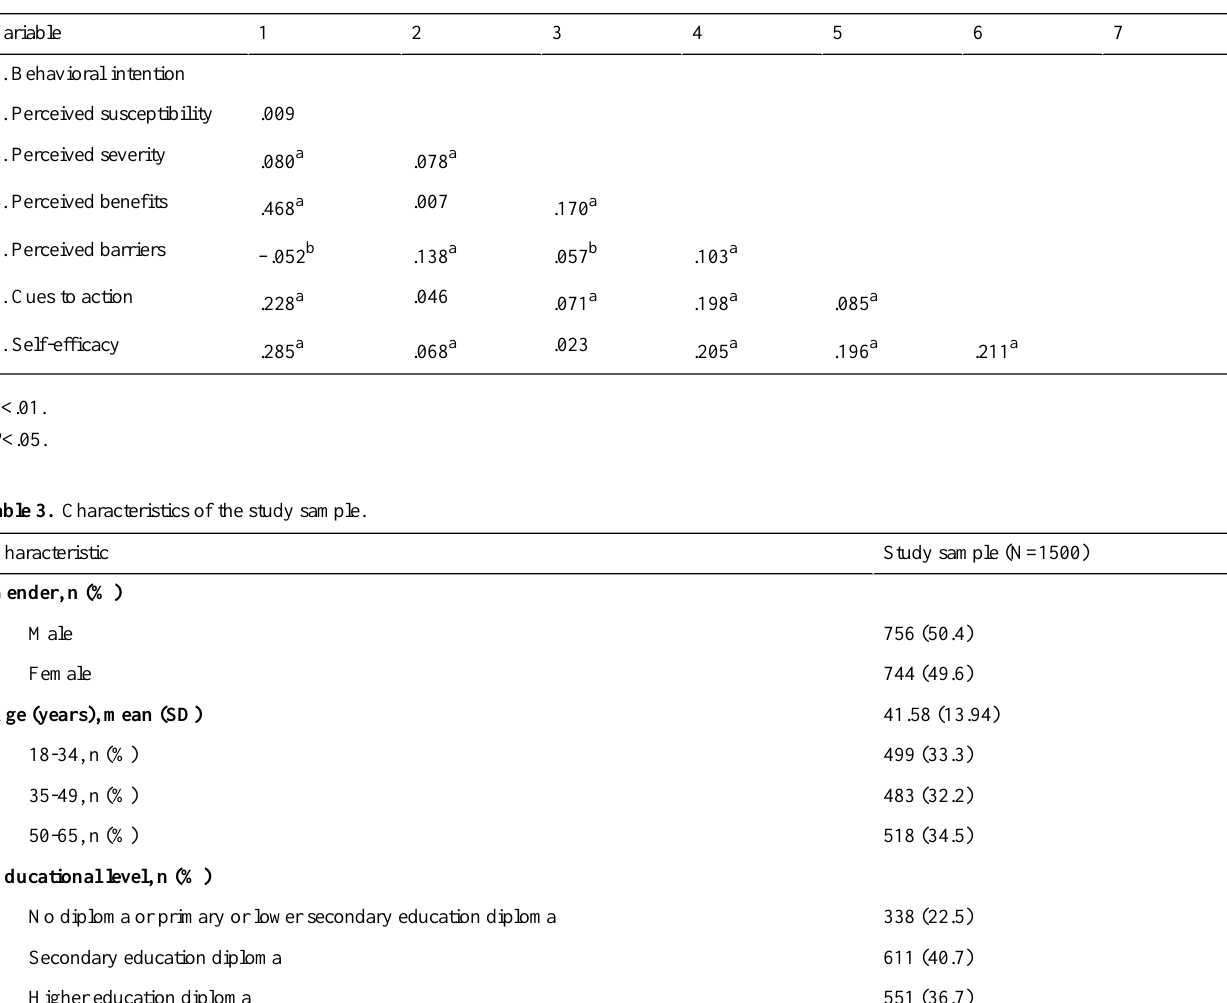
Table 2. Correlation matrix of latent variables.